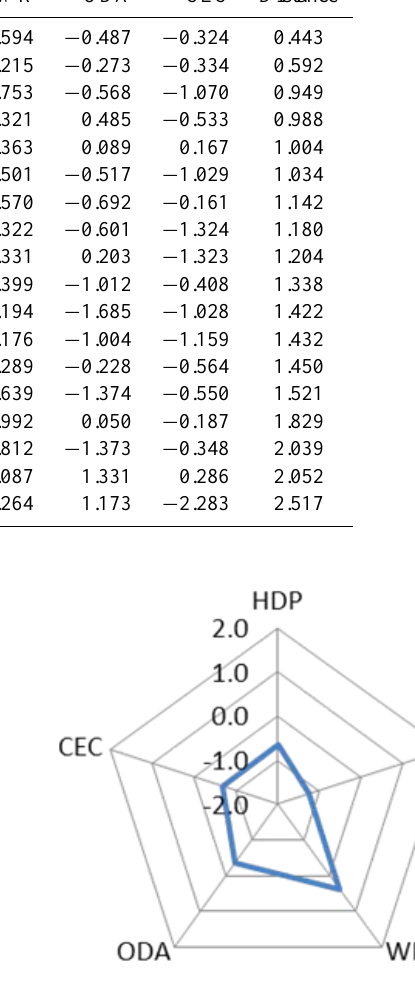
Fig. 9. Profile 5 – this profile shows low values either in human development (HDP) and accountability toward population and en- vironment (CEC). Because of the political instability or violence within the country, external aid remains low. The environmental concern may be undermined by the type of economy, mainly based on raw material or natural resources